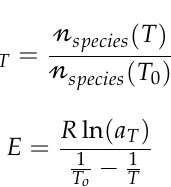
Figure 7. Specific crosslink density: ( a ) Crosslinks due to hydrosilylation for Controls; ( b ) Crosslinks due to hydrosilylation for 0pt2; ( c ) Water fraction for Controls; and ( d ) Water fraction for 0pt2.